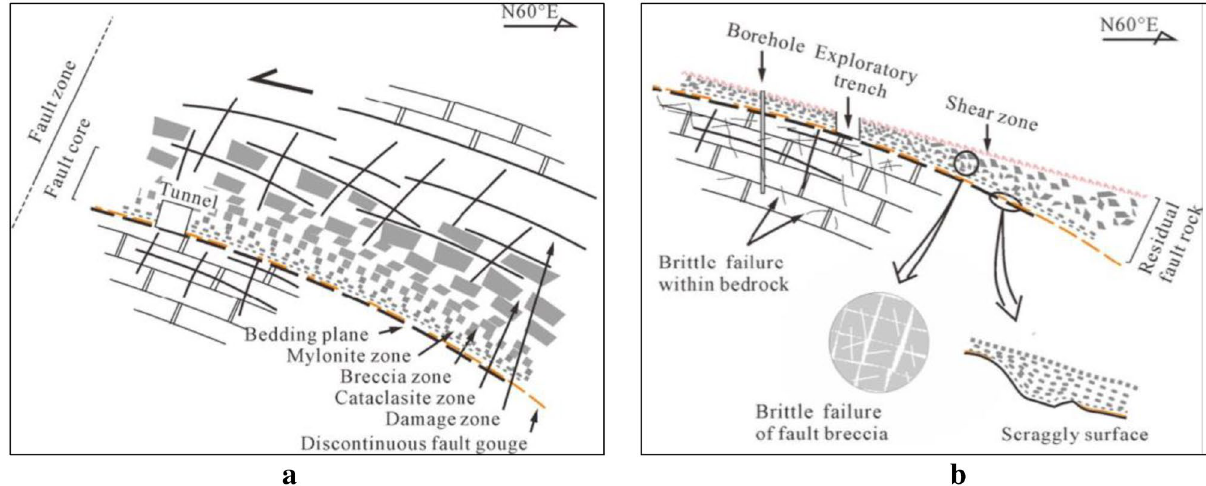
Figure 2. Geological model of the sliding zone of DGB landslide ( a ) Before DGB landslide; ( b ) After DGB landslide (Modified from Cui et al. 18 ).